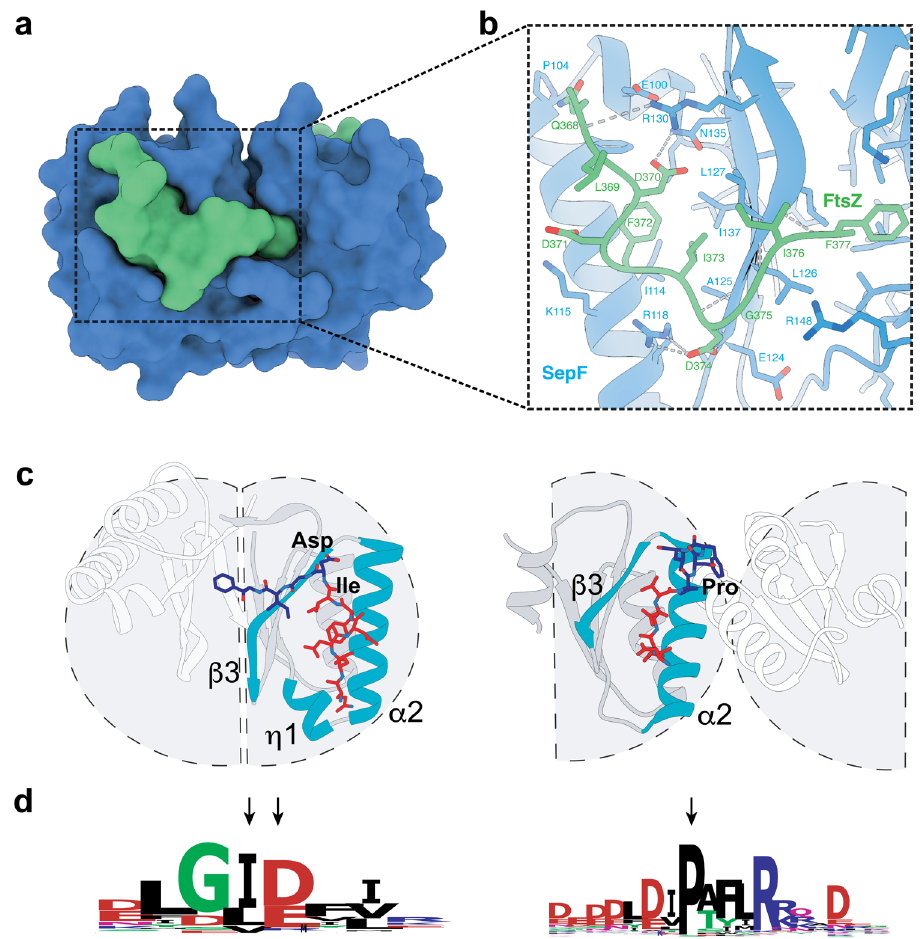
Fig. 4 The SepF-FtsZ CTD complex. a Surface representation of the crystal structure of FtsZ CTD (green) bound to MsSepF core (blue). b Detailed protein- protein interactions within the binding pocket. The side-chains of contact residues ( d < 5 Å) are shown in stick representation and hydrogen bonds are represented by gray dotted lines. c Cartoon representations of the different functional dimers of archaeal MsSepF (left panel) and bacterial CgSepF (right panel) bound to FtsZ CTD (for clarity, only one of the two bound peptides is shown in stick representation). The N-terminal half of FtsZ CTD (in red) binds to a similar groove of the SepF monomer formed between secondary structure elements α 2, β 3 and η 1 (only in MsSepF), shown in turquoise. Highly conserved positions in archaeal and bacterial FtsZ CTD are labeled. d Sequence conservation logo of archaeal (left) and bacterial (right) FtsZ CTD sequences. The arrows indicate the highly conserved residues across Archaea or Bacteria that are labeled in panel c